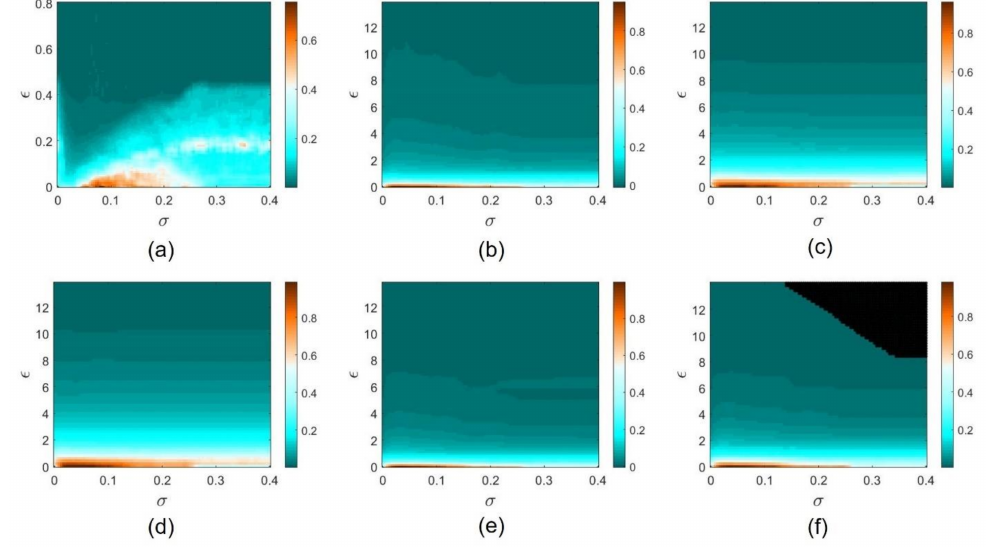
Figure 4. A 2D representation of the interlayer synchronization error ( E ) in the ( σ , (cid:101) ) plane by considering different fractional-order derivatives for the layers: ( a ) q 1 = q 2 = 1; ( b ) q 1 = 1, q 2 = 0.9; ( c ) q 1 = 1, q 2 = 0.8; ( d ) q 1 = 1, q 2 = 0.7; ( e ) q 1 = 0.9; q 2 = 0.8, ( f ) q 1 = 0.8, q 2 =